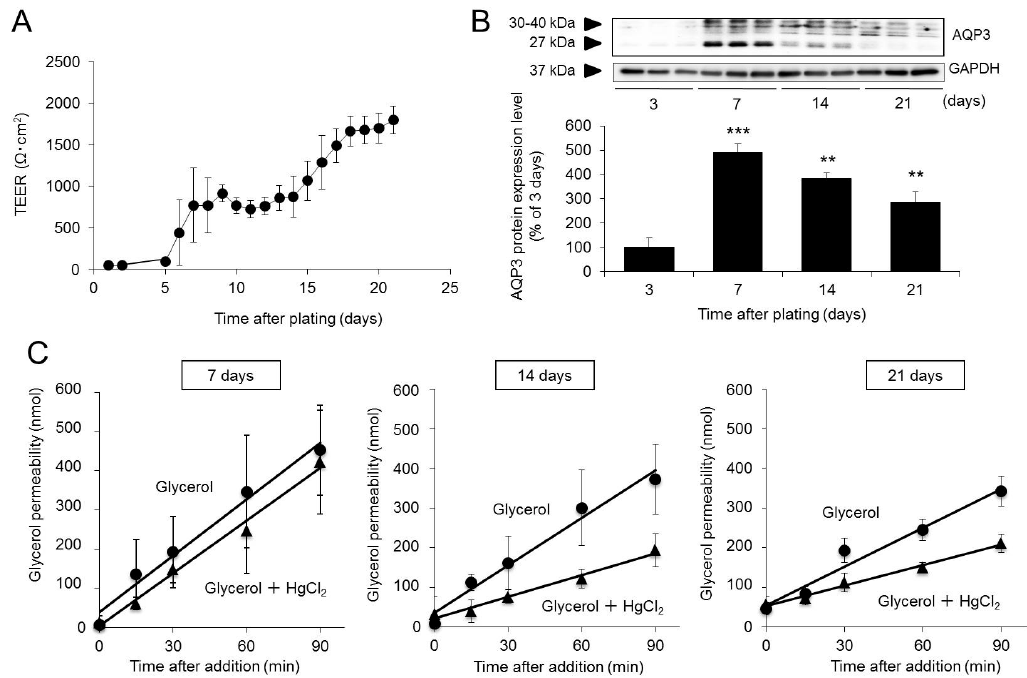
Figure 1. Changes in the expression and function of Aquaporin-3 (AQP3) during Caco-2 cell differentiation. Caco-2 cells were plated in Transwell plates and incubated for 3, 7, 14, or 21 days. ( A ) The integrity of the monolayer was measured by determining the TEER. ( B ) The protein expression of AQP3 was analyzed by western blotting and normalized to glyceraldehyde-3–phosphate dehydrogenase (GAPDH) expression. The mean levels of AQP3 protein expression on day 3 of incubation are indicated as 100%. ( C ) Glycerol alone or a combination of glycerol and HgCl 2 was added to the apical side of the Transwell plate. The concentration of glycerol on the basal side was measured to calculate the permeated amount of glycerol. The data are presented as the mean ± SD for six experiments. Dunnett’s test: ** p < 0.01 and *** p < 0.001 vs. the day 3 value. Table 1. P app of glycerol during Caco-2 cell differentiation.